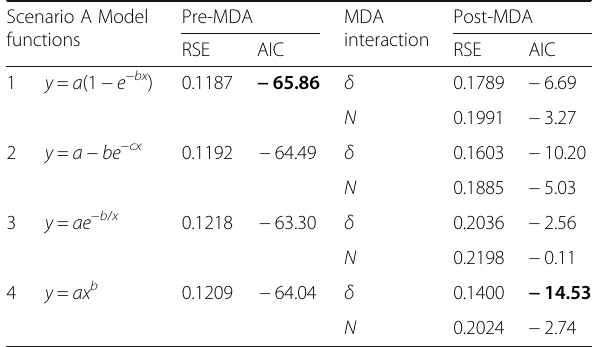
Table 1 Comparison of the Differentiated Scenario A models Scenario A Model functions